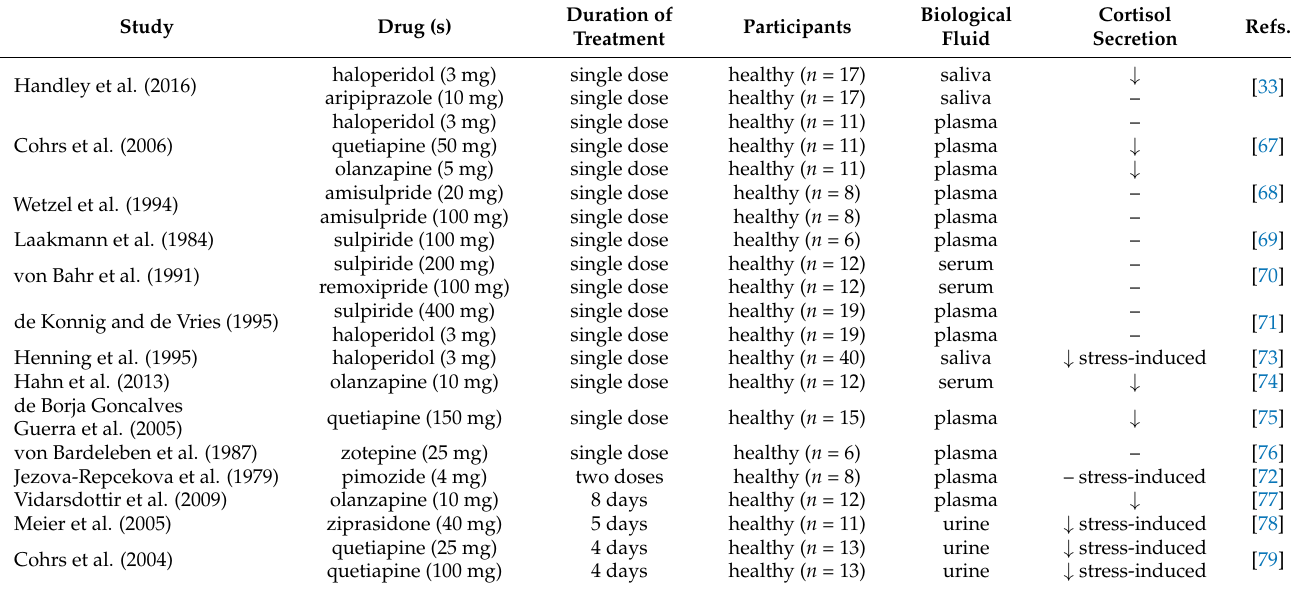
Table 1. Summary of findings from studies investigating changes in cortisol concentrations following antipsychotic drug treatment in healthy